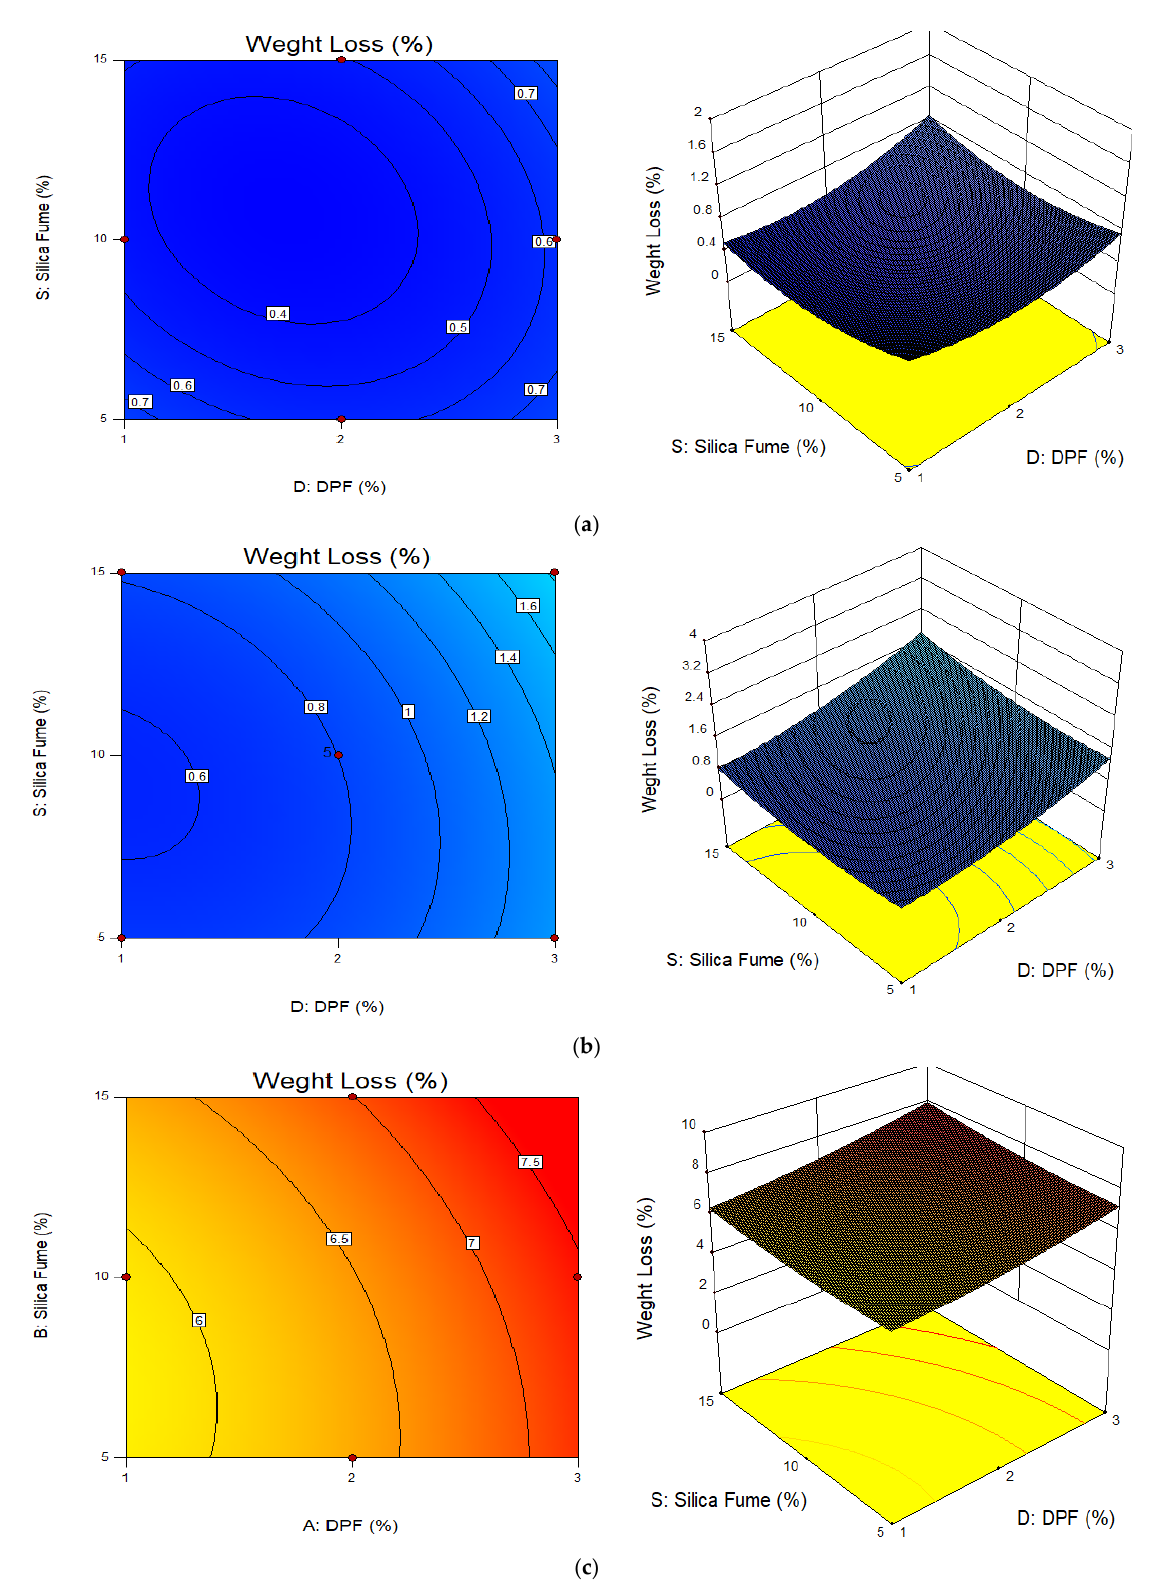
Figure 6. 2D contour and 3D response surface plots for weight loss. ( a ) Temperature 200 °C; ( b ) temperature 400 °C; ( c ) temperature 600 °C.